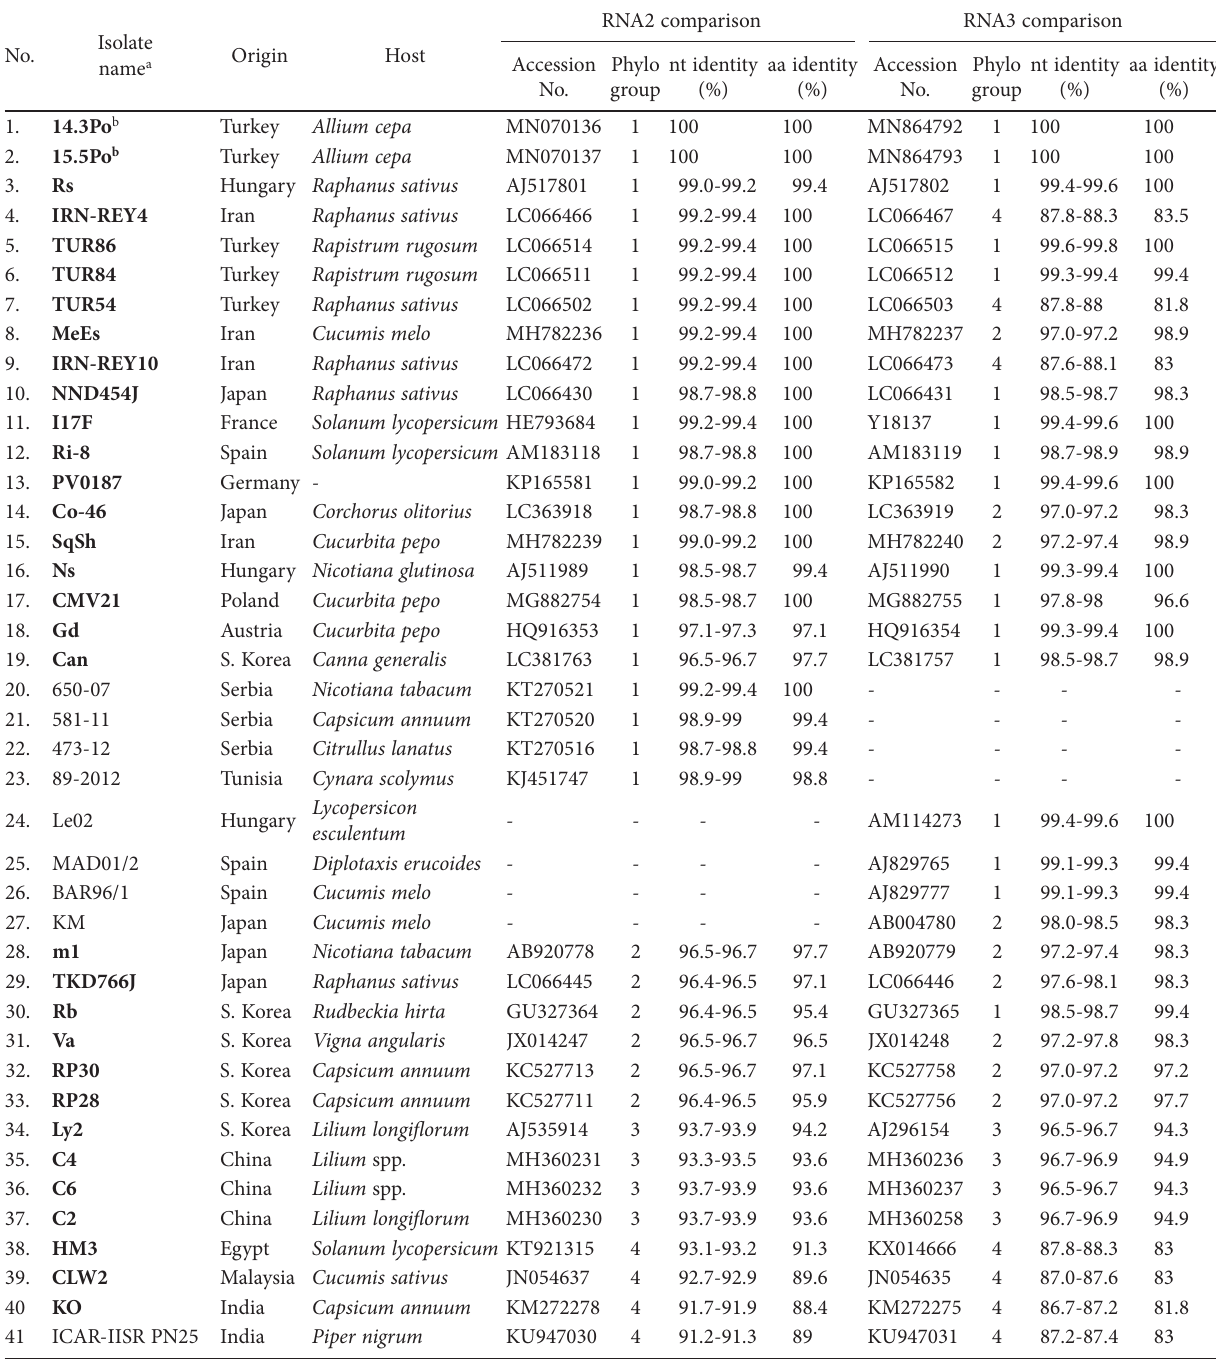
Tabel 1. CMV isolates used in this study. The partial RNA2 and RNA3 nucleotide and amino acid sequence percentages to onion isolates are